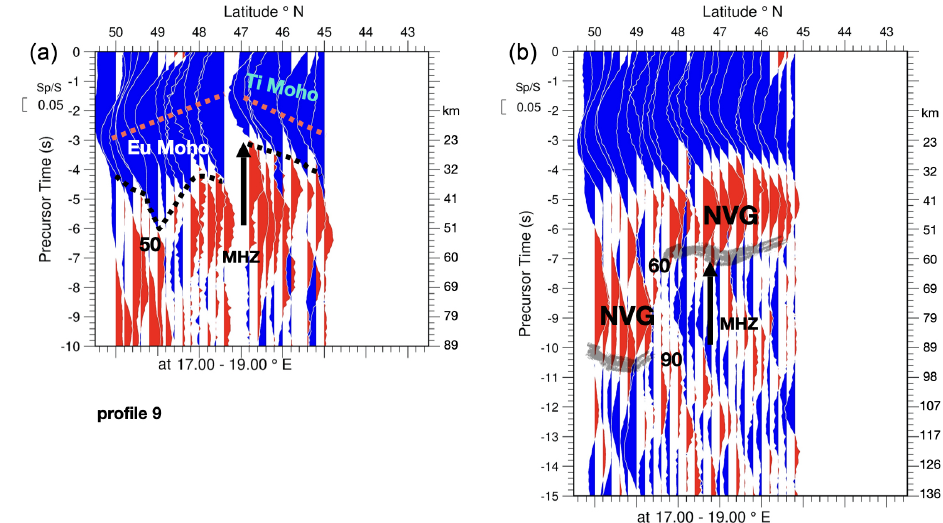
Figure 11. Profile 9. North–south profiles at 17–19 ◦ E. As in the profile 8 in Fig. 10, the Moho culminates in the area of the Mid-Hungarian Fault Zone (MHZ) marked with a black arrow, located in the centre of the Pannonian Basin. In this profile the MHZ denotes the boundary of the substantially thinned European crust of the northern part of the Pannonian Basin with the shallow Moho of the southern part of the Pannonian Basin (south of lake Balaton, marked TI Moho) that belongs to the Tisza mega-unit (see Schmid et al., 2008). The dashed red line in (a) approximately marks the maxima of the Moho